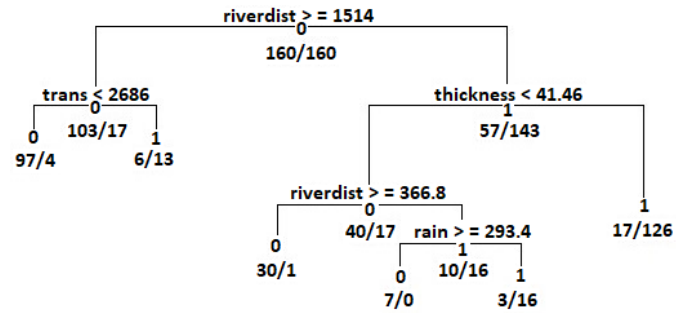
Figure 8. The pruned classification tree by the CART, riverdist: distance from rivers, trans: transmissivity, thickness: aquifer thickness, and rain: rainfall.